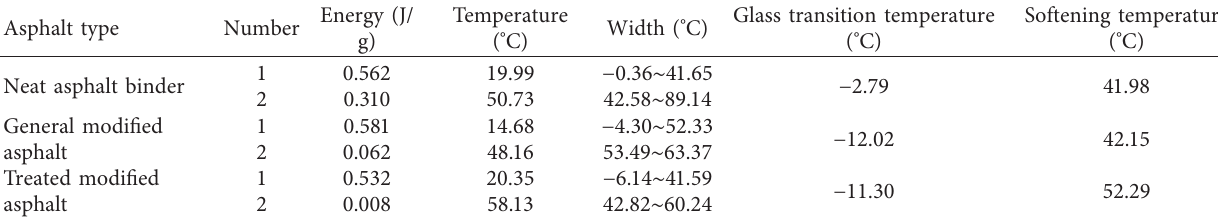
Table 5: DSC test results